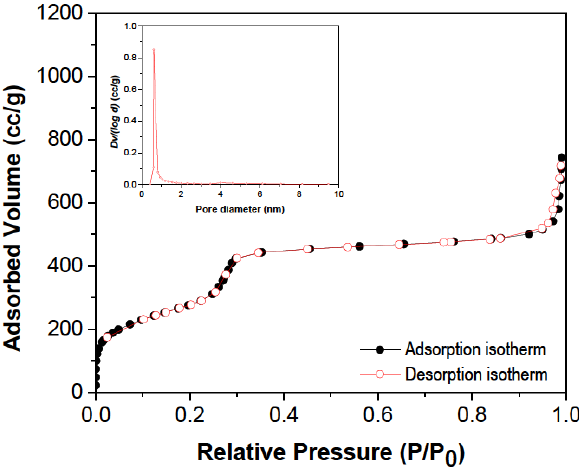
Figure 5: Nitrogen adsorption-desorption isotherms of the MNPSiO 2 sample. The insert corresponds to its pore size